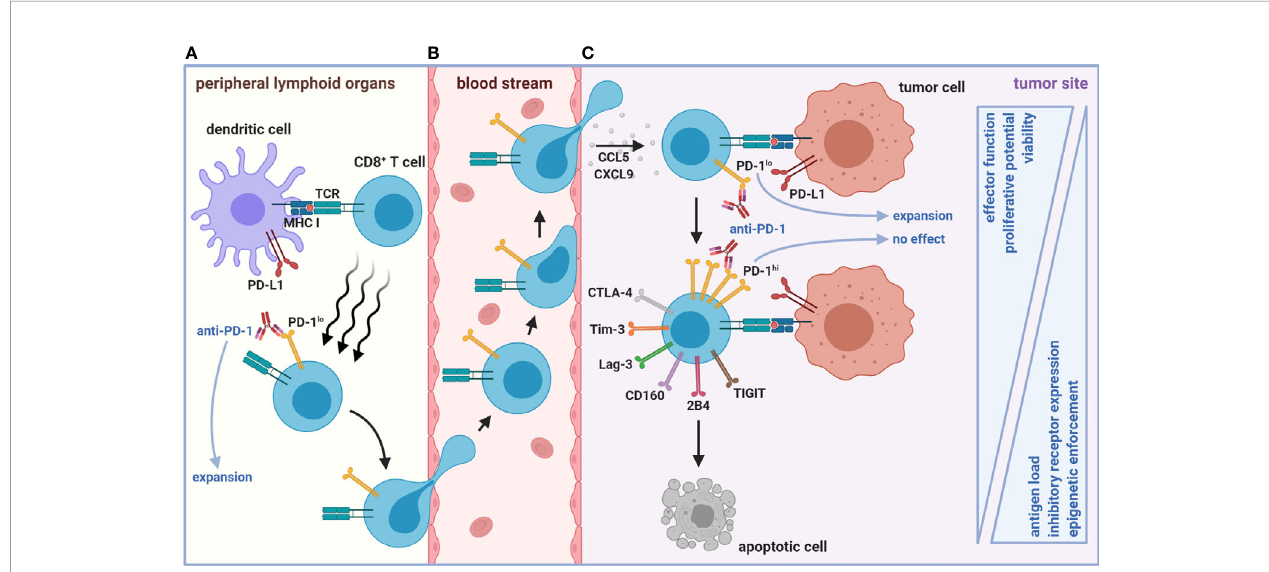
FIGURE 2 | Spatiotemporal organization of early versus late stages of tumor-mediated CD8 + T cell dysfunction. (A) Naïve CD8 + T cell priming against tumor antigen in peripheral LNs (or intratumoral TLS, not depicted) results in the formation of a stem-like PD-1 lo CD8 + T cell population with self-renewing properties. (B) This population represents an active reservoir of cells that can give rise to effector-like PD-1 lo CD8 + T ex after chemokine-mediated traf fi cking to and positioning within the TME via CCL5 and CXCL9. (C) However, persistent antigen load in the TME eventually forces continued differentiation of these cells into terminally dysfunctional PD-1 hi CD8 + T ex . The PD-1 hi state is accompanied by heightened co-inhibitory receptor expression (including Tim-3, Lag-3, CD160, 2B4, TIGIT, and CTLA-4) and progressive loss of effector functions. Once CD8 + T ex enter a PD-1 hi state, epigenetic enforcement prevents de-differentiation back to functional stem-like and effector-like PD-1 lo states. Anti-tumoral responses facilitated by ICB ( e.g. , anti-PD-1) arise from expansion from only lymphoid or intratumoral PD-1 lo CD8 + T ex subsets. The functionally inferior, ICB-resistant PD-1 hi CD8 + T ex fate ultimately culminates in